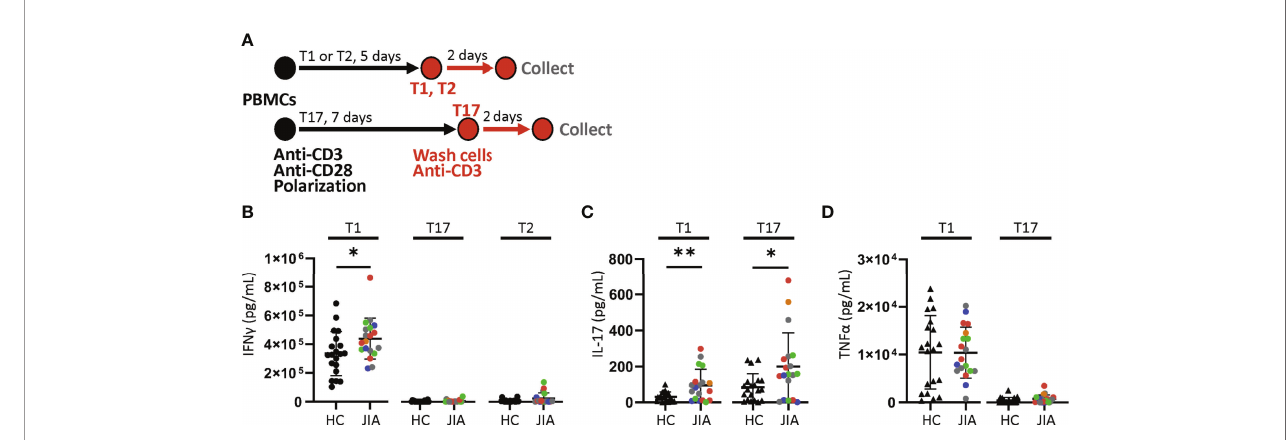
FIGURE 2 | Increased production of IFN g and IL-17 from JIA polarized T cells. T1, T2, and T17 cells were polarized in vitro from child healthy control (HC) and JIA PBMCs. JIA are colored based on current use of methotrexate (green), biologic (blue), methotrexate and biologic (gray), prednisone (orange), and none or NSAID (red). (A) Schematic of polarization showing PBMCs treated with anti-CD3, anti-CD28 and polarization conditions for 5 days for T1 and T2 cells or 7 days for T17 cells. The polarization media is then removed, cells are washed, new media without polarization factors added, and activated with anti-CD3. After 2 days, the produced cytokines were analyzed by ELISA. (B) IFN g produced by T1, T17, and T2 cells for HC and JIA with new diagnosis JIA denoted (red circle). (C) IL-17 produced by T1 and T17 cells for HC and JIA with new diagnosis JIA denoted (red circle). IL-17 was below detection for T2 cells. (D) TNF a produced by T1 and T17 cells for HC and JIA with new diagnosis JIA denoted (red circle). TNF a was below detection for T2 cells. HC (N=20) and JIA (N=19). Shown is mean with standard deviation. Analysis by Welch ’ s t-test *p < 0.05, **p < 0.01.